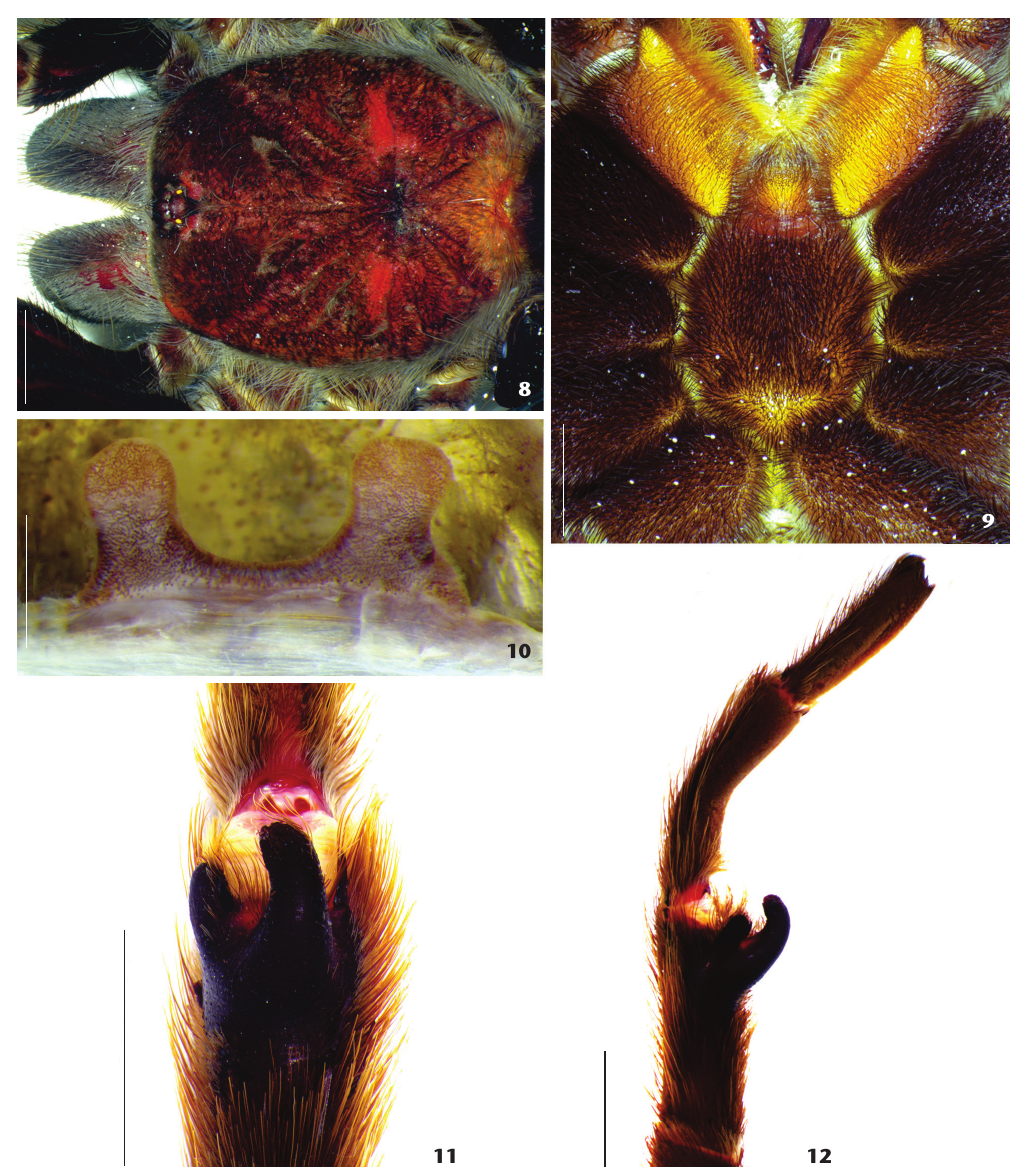
and tibiae, a single short conspicuous white stripe on basal meta- tarsi. Abdomen black with long brown setae on dorsum (Fig.